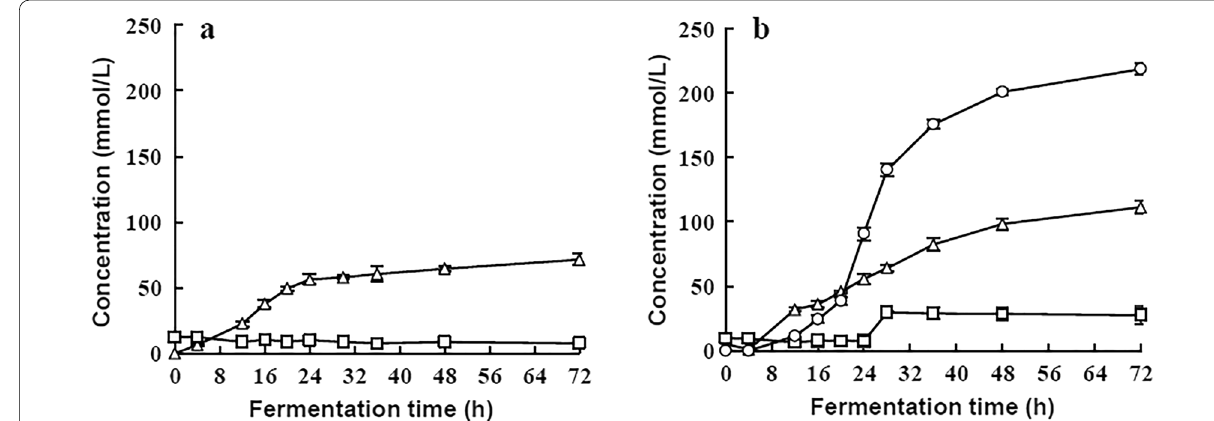
Fig. 4 The products in aerobic ( a ) and anaerobic ( b ) fermentation. Products tested: Lactate